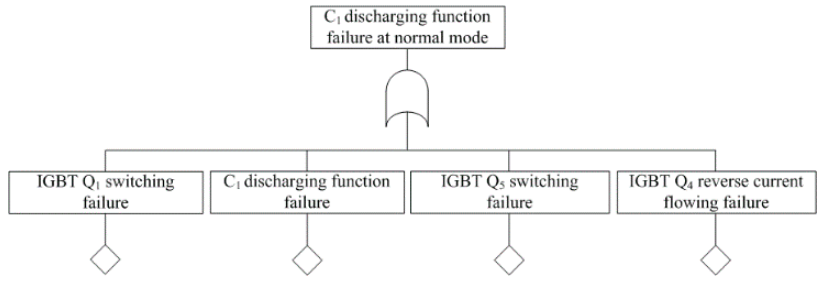
Figure 10. Sub fault tree for C 1 discharging function failure at normal mode.